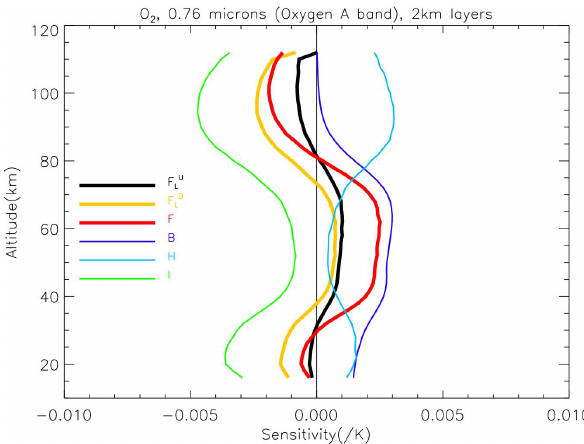
Fig. 5. Same as Fig. 3 but for O 2 A-band.